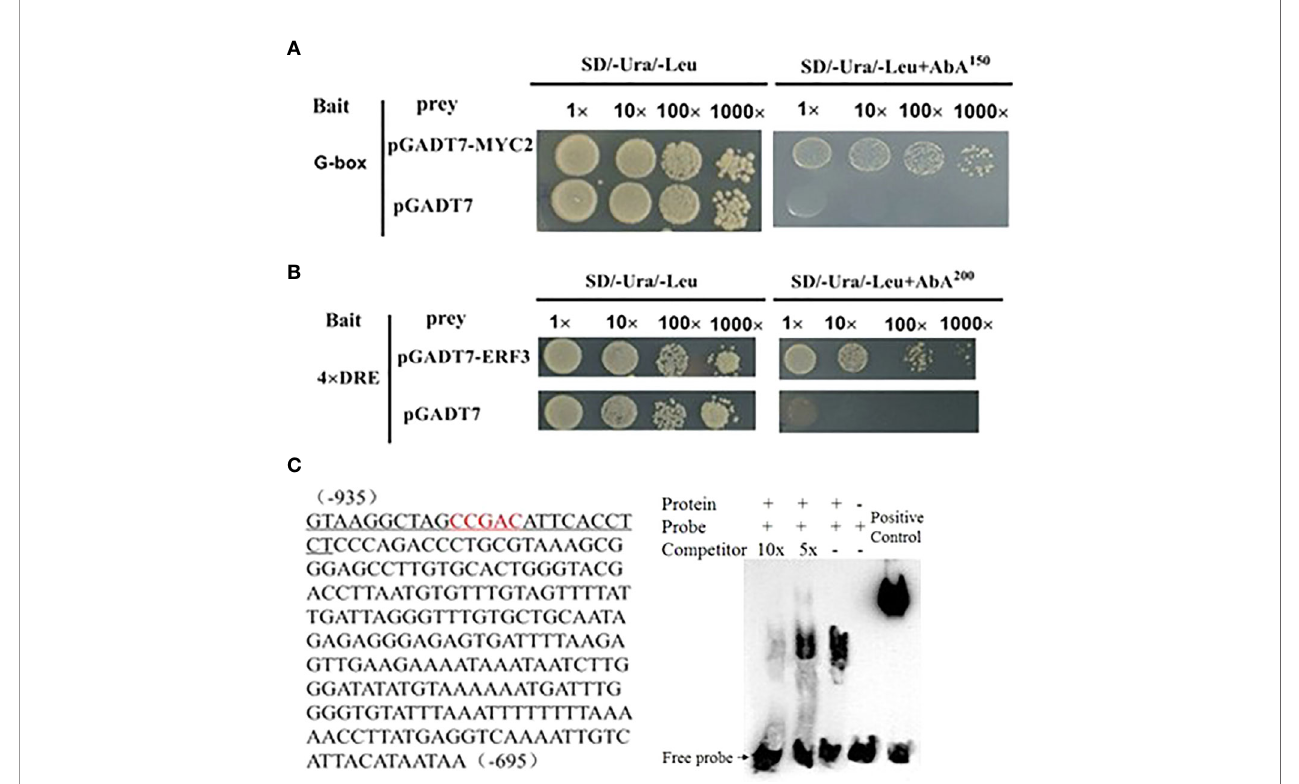
FIGURE 3 | MdMYC2 and MdERF3 bind to the MdAFS promoter. (A, B) Yeast one-hybrid analysis of MdMYC2 and MdERF3 binding to MdAFS promoter. (C) EMSA indicating that MdERF3 directly bound to the MdAFS promoter at CCGAC in vitro . Biotin-labeled probes were incubated with MdERF3 protein and then separated in an acrylamide gel. The competitors were unlabeled